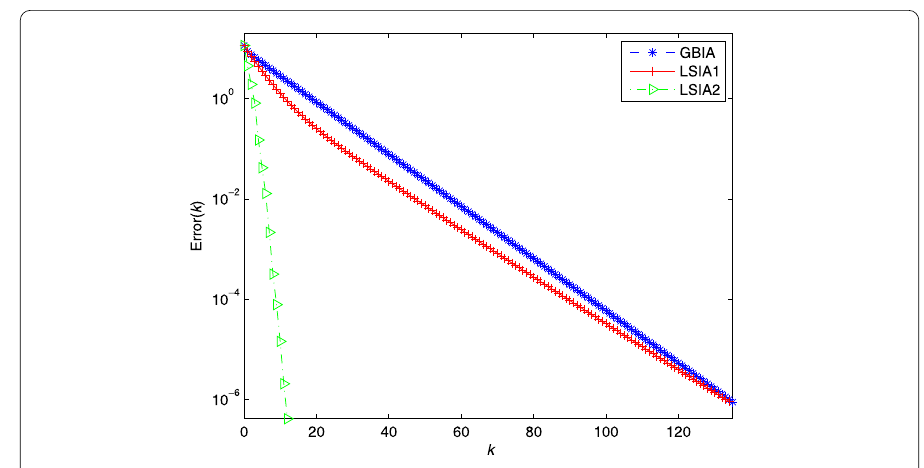
Figure 3 Numerical results of LSIA1, LSIA2, and